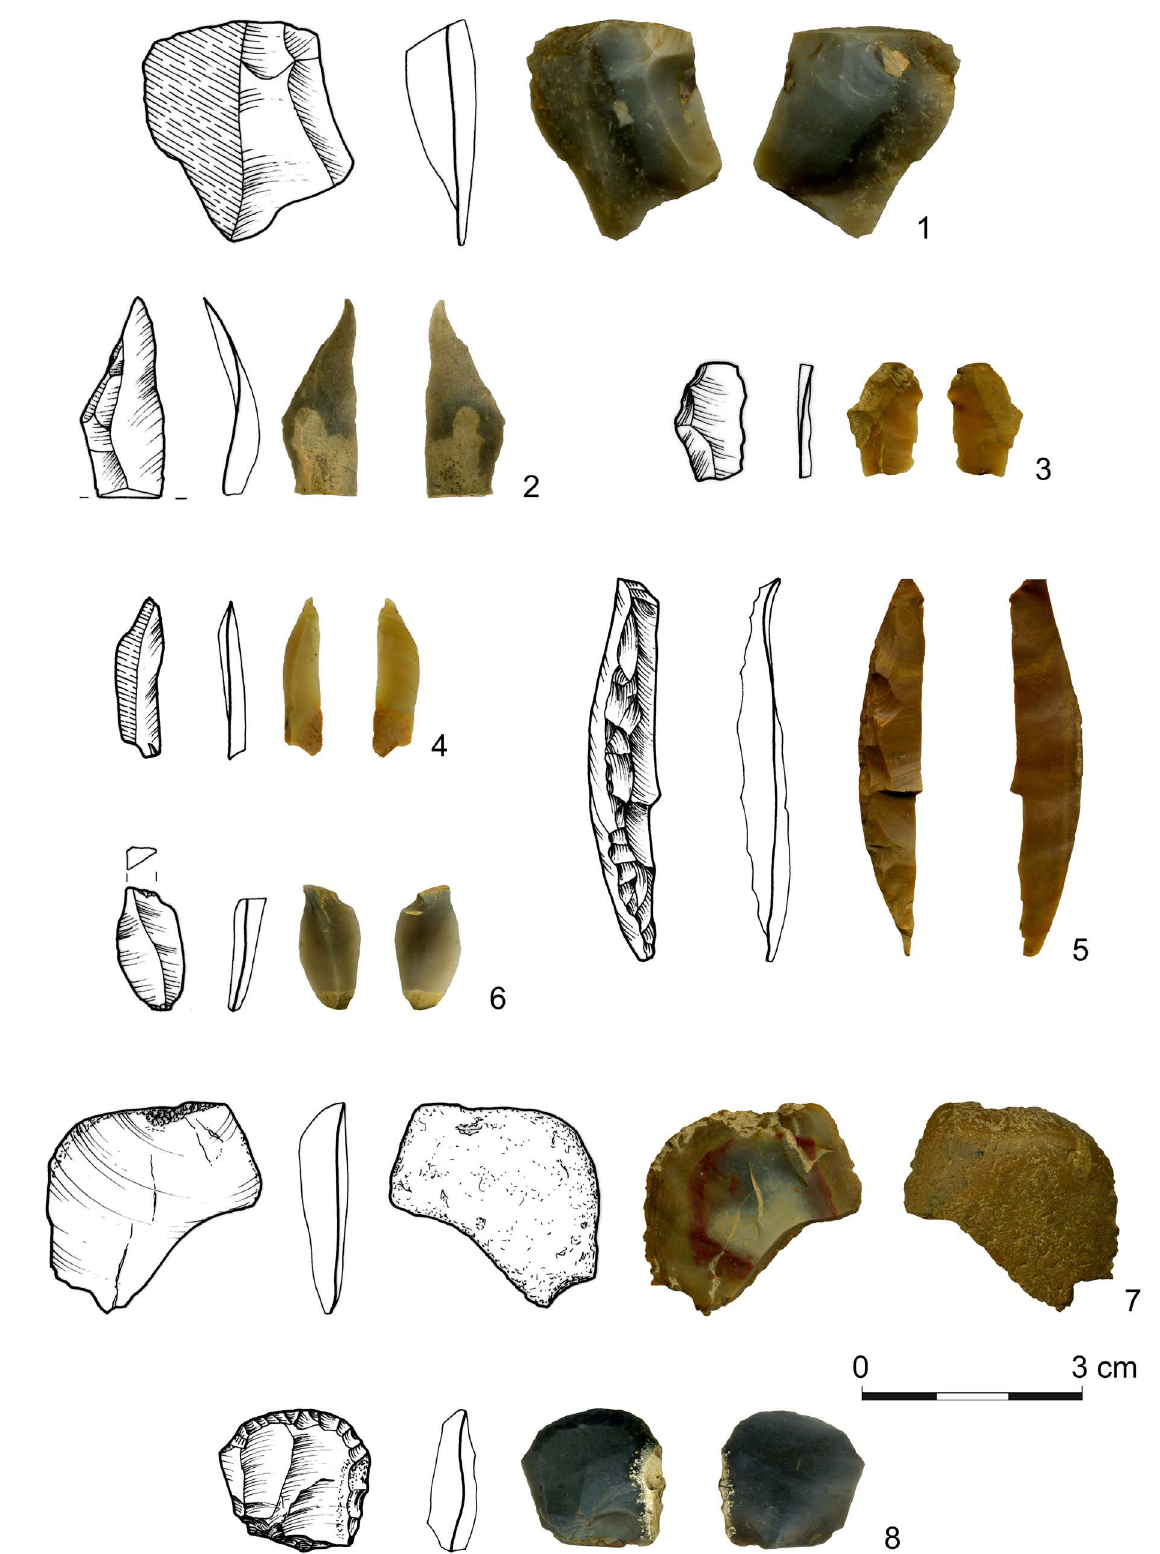
Figure 2. Weklice, Elbląg county. Flint artefacts: 1. flake with negative flake scars on the dorsal surface; 2. fragment of a blade with scars on the dorsal surface; 3. flake with negative flake scars on the dorsal surface; 4. blade with scars on the dorsal surface; 5. secondary crested blade; 6. flake with negative flake scars on the dorsal surface; 7. initial flake; 8. endscraper. (Drawing by E. Gumińska, E. Pazyna and D. H. Werra. Photo by M. Natuniewicz-